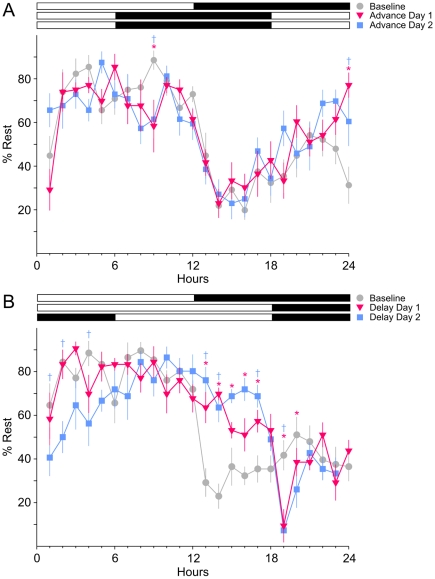
Phase advance of the LD cycle alters the distribution but not the total amount of sleep.A single cohort (n = 8) of adult male mice were entrained to a 12∶12 LD cycle for 2 weeks. The mice were videotaped for 24 hrs to establish a baseline and an additional 48 hr during which the mice were subjected to a 6 hr phase shift of the LD cycle. The video was scored every 5 min to determine if the mice were awake or asleep. In both A and B, the significant differences between baseline and the first day of the phase shift as determined by 2RM ANOVA with post-hoc Bonferroni's t-tests are denoted by “*” and the significant differences between baseline and the second day of the phase shift by “†”. A) A 6 h phase advance of the LD cycle did not change the total amount of sleep over a 24 h cycle compared to the baseline recordings, but resulted in minor changes in the distribution of sleep. B) A 6 h phase delay of the LD cycle resulted in increased sleep during and after the phase shift, and caused an immediate increase in sleep during the extended 6 h of light, as well as a corresponding decrease in sleep during the dark hours of the following day.